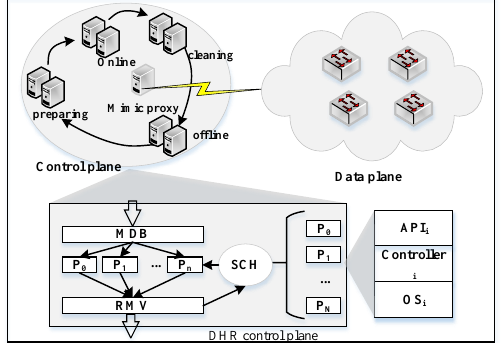
Figure 2. The DHR architecture of control plane in SDN.